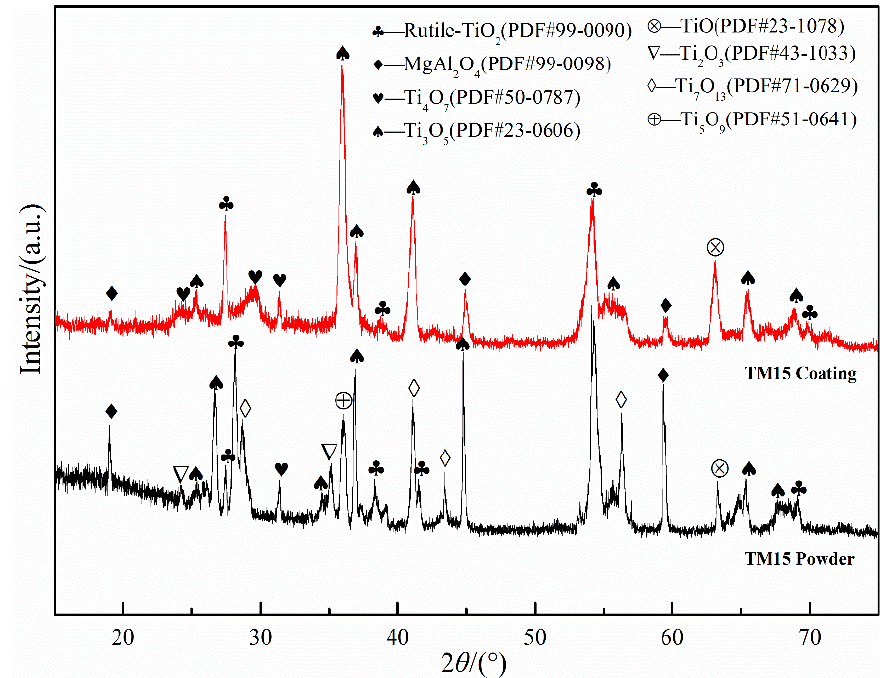
Figure 2. XRD patterns of TiO 2 -15MgAl 2 O 4 powder and coating.